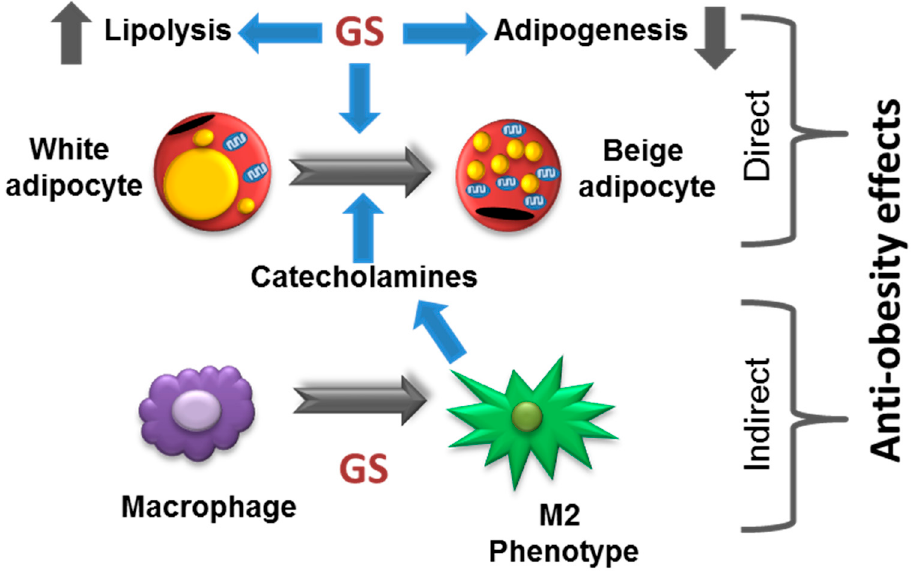
Figure 7. Proposed model of anti-obesity effects of GS.